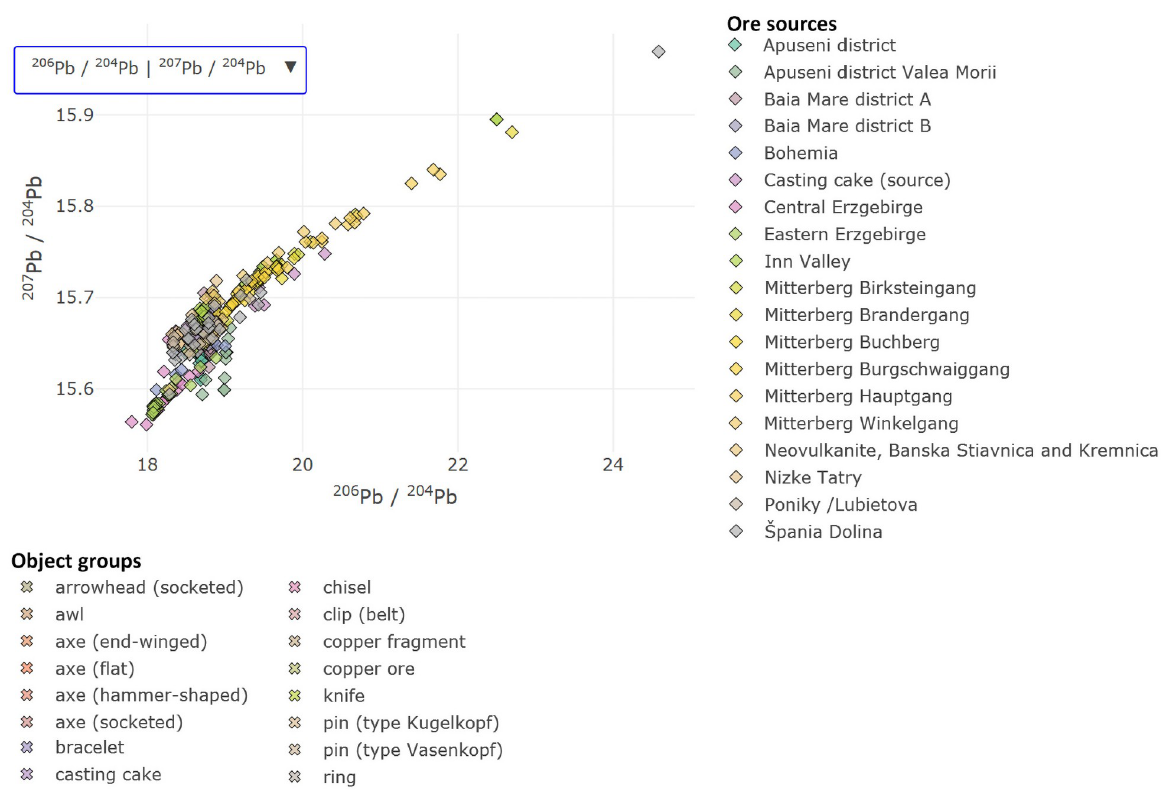
Fig 7. Bivariate lead isotope plot with isotope ratio comparison pulldown menu. The included supplemental data file allows for interactive zooming and data comparison, hiding data points, and saving still images. The data for these diagrams derive from [9, 44, 46, 54–58, 62, 63].